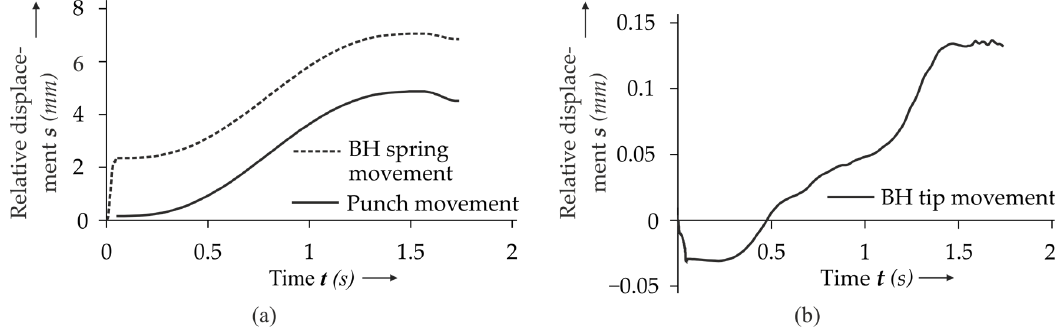
Figure 4. Blank holder spring compression and punch movement ( a ) and the resulting blank holder tip movement ( b ).